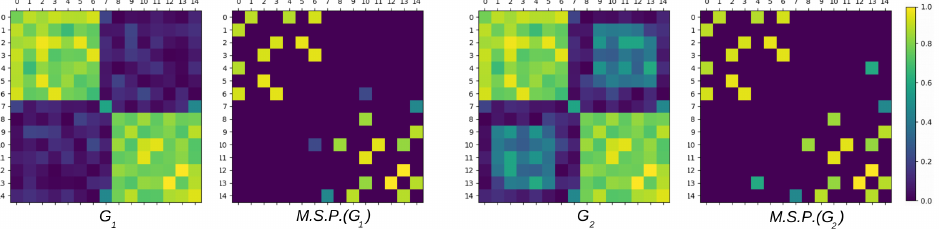
Figure A1. Adjacency matrices of the simulated graphs G 1 and G 2 of Appendix A and their maximum spanning trees